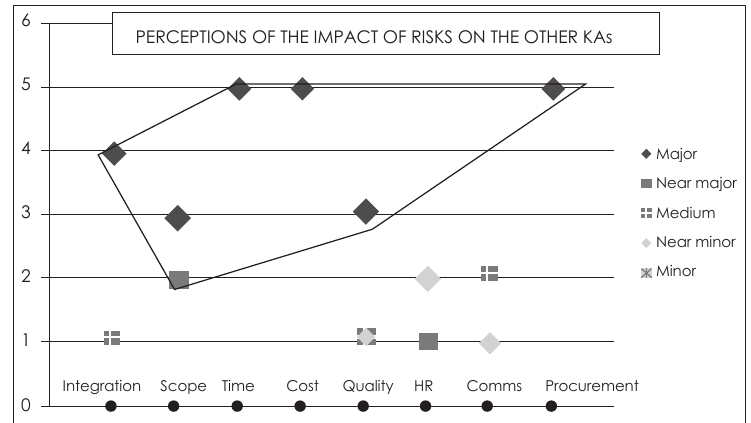
Figure 3: Case 1 – summarised perceptions of the impact of risks on the other KAs throughout the PLC Figure 3 indicates how interviewees perceived the impact of risk on the other functional areas of the project. Some red dots (representing P-Is) appear to be dominant in the top tier of the diagram,